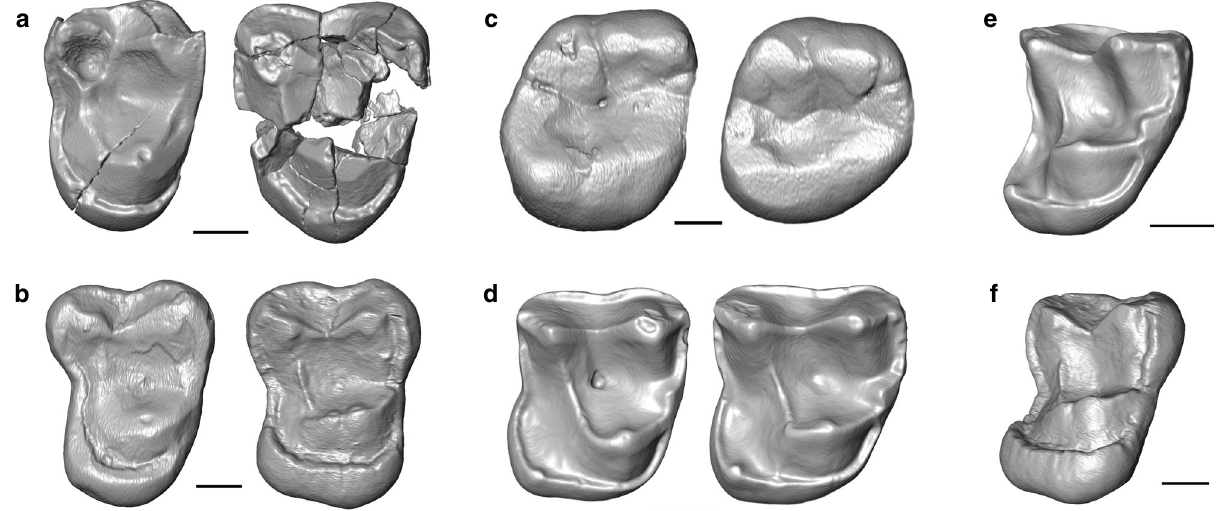
Fig. 4 Upper molars of early African strepsirrhines and extant Daubentonia from Madagascar. a Left M 1 (on right) and M 2 (on left) of DPC 12393, partial cranium of Plesiopithecus teras (latest Eocene, Quarry L-41, Fayum Depression, Egypt); reversed for comparison, the M 1 is badly damaged and has been digitally reconstructed by segmenting out multiple fragments and repositioning them, while the M 2 is lacking much of the buccal margin; b isolated right M 1 [KNM-CA 1796, on right] and M 2 [KNM-CA 1797, on left] of Propotto leakeyi (early Miocene, Chamtwara, western Kenya); c right M 1 (on right) and M 2 (on left) of AMNH M-41334, adult Daubentonia madagascariensis individual from Madagascar, locality unknown; d right M 1 [on right, DPC 21639C] and M 2 [on left, DPC 21636E] of Karanisia clarki (earliest late Eocene, Quarry BQ-2, Fayum Depression, Egypt); e oblique mesial view of DPC 21639C, right M 1 of earliest late Eocene Karanisia clarki , showing the tall primary cusps, low parastyle, low lingual cingulum, and paraconule typical of early strepsirrhines; f oblique mesial view of KNM-CA 1796, right M 1 of Propotto leakeyi , showing the low primary cusps, relatively tall parastyle, tall lingual cingulum, and absence of paraconule that is characteristic of this species. Scale is equal to 1 mm. Digital models were created using CT scans made available by the Duke Lemur Center Division of Fossil Primates and the National Museums of Kenya, which were downloaded from www.morphosource.org and made